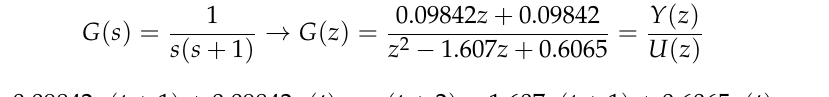
Figure 2. Representative Direct Current (DC) motors used as actuators for unmanned underwater vehicles (modeled in Equations (1) and (2) as described in [8]). ( a ) Marine Propeller DC motor [32]. ( b ) Unmanned Systems Technology DC motor [33]. ( c ) Maxon EC-i 40 DC motor [34]. ( d ) Galco Industries DC Motor [35].